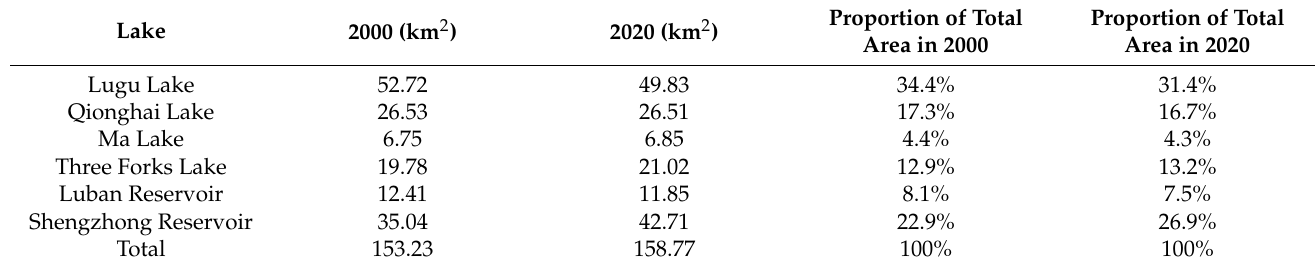
Table 9. Comparison of the area percentage of each lake in 2000 and